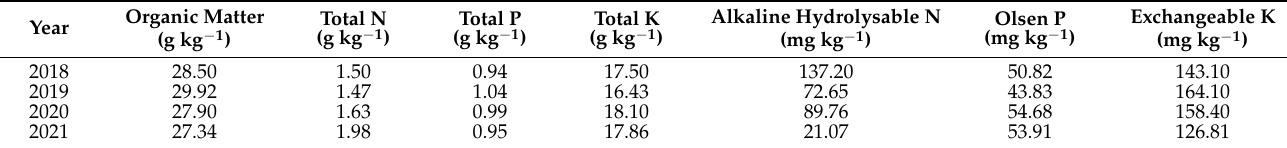
Table 5. Soil properties of experimental sites between 2018 and